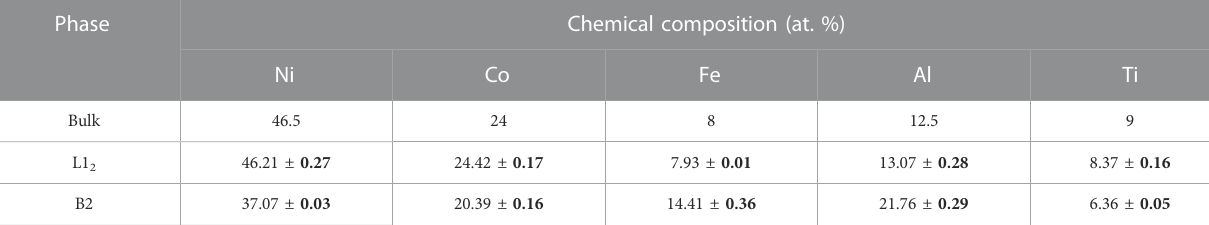
TABLE 1 Phase composition of the Ni 46.5 Co 24 Fe 8 Al 12.5 Ti 9